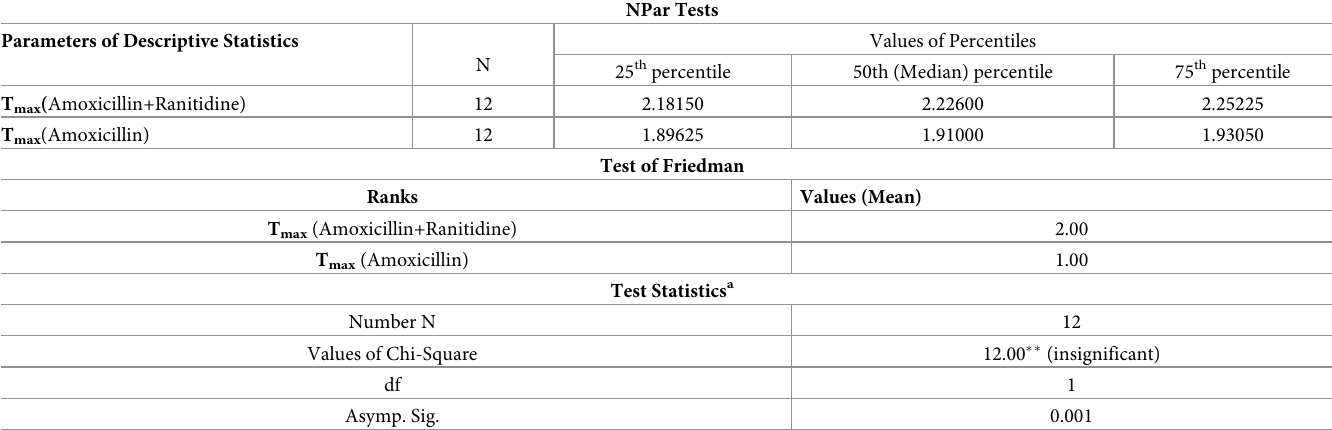
Table 4. NPar and FRIEDMAN Analysis for differentiation of T max for amoxicillin alone and in combination with ranitidine.